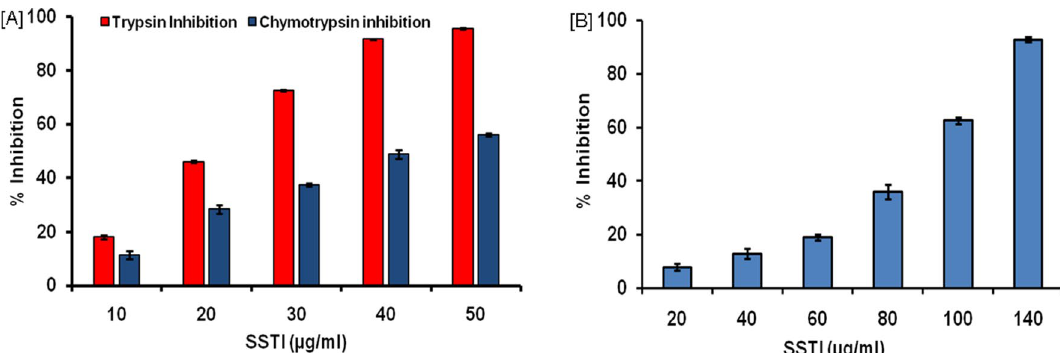
Figure 2. Concentration dependent inhibition of ( A ) Trypsin and Chymotrypsin ( B ) Gut proteases by Purified